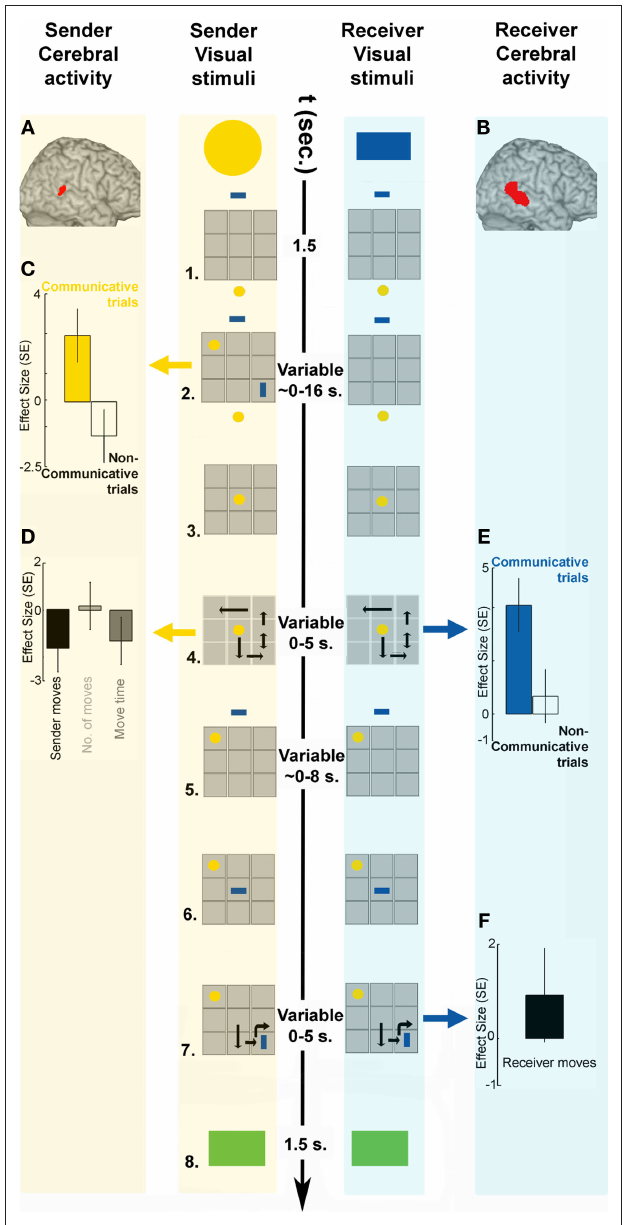
FIGURE 2 | Sequence of events in a COMMUNICATIVE trial of the TCG (all conventions as in Figure 1), and cerebral activity evoked in the sender and in the receiver during relevant trial epochs. (A) Planning communicative actions increased metabolic activity in the posterior part of pSTS of the sender’s brain (in red, MNI coordinates: 50, − 42, 14, p < 0.05 corrected for multiple comparisons).as compared to planning similar movements during NON - COMMUNICATIVE trials [ (C) ; effect size: parameter estimates of a multiple regression analysis in standard error (SE) units], i.e. trials in which both players could see the goal confi guration. The execution of the movements evoked no signifi cant changes in the right pSTS activity of the sender’s brain (D) . The observation of the same communicative actions increased right pSTS activity in the receiver’s brain [ (B) , in red, MNI: coordinates: 56, − 38, 6, p < 0.05 corrected for multiple comparisons], as compared to observing the same movements during non-communicative trials (E) . The execution of the movements evoked no signifi cant changes in the pSTS activity of the receiver’s brain (F) .